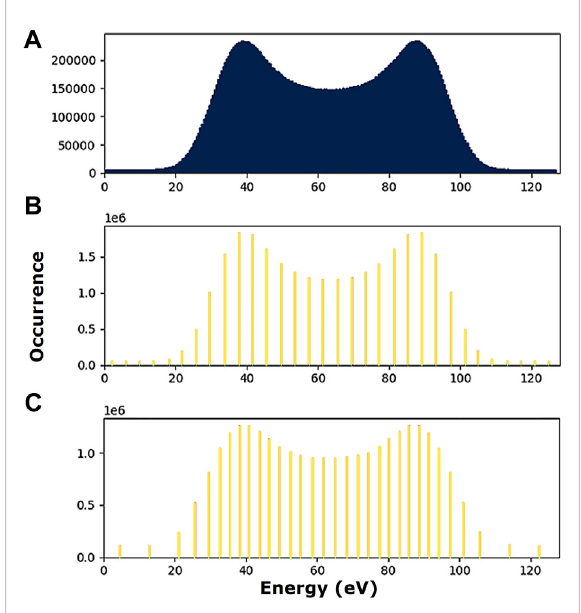
FIGURE 2 5-bit uniform quantization (B) and 5-bit optimized nonuniformquantization (C) effectontheoriginaldatadistribution (A) . The Lloyd-Max algorithm gives more granularity to the ranges where the data are more occurring within the distribution which maximizes the entropy and minimizes the mean-square error when